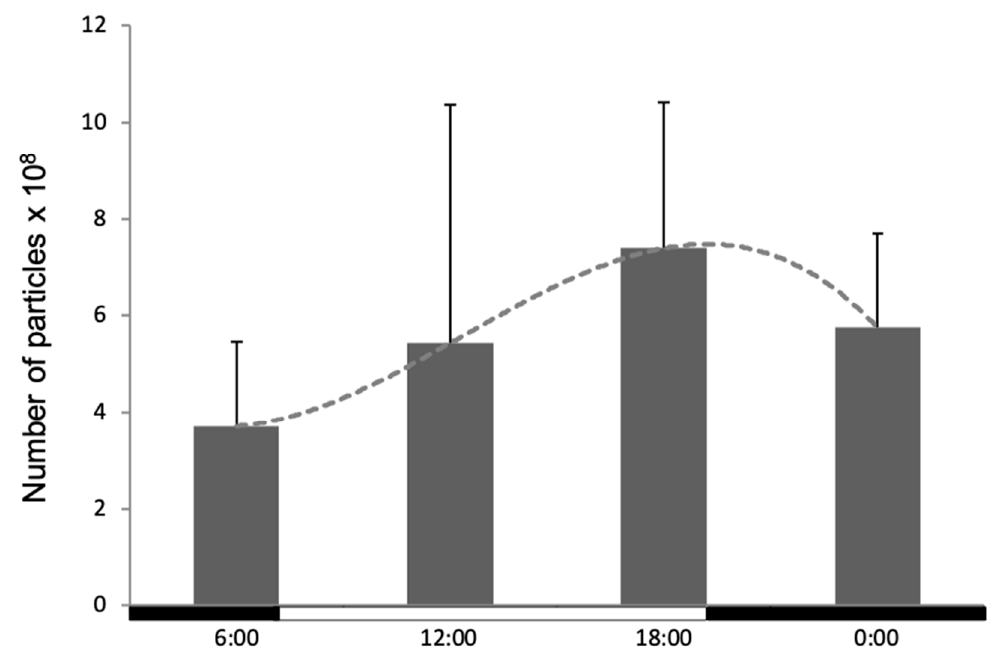
Figure 5. Evaluation of the antimicrobial activity of sera obtained at several time points. Data represent the number of bacteria which grew after a 24-h culture. The data is presented as mean values with SD error bars. The statistical test used was one-way ANOVA with the Bonferroni post hoc test considering p ≤ 0.05. No statistically significant differences were obtained. The white and black bars on the x-axis represent the dark/light period.